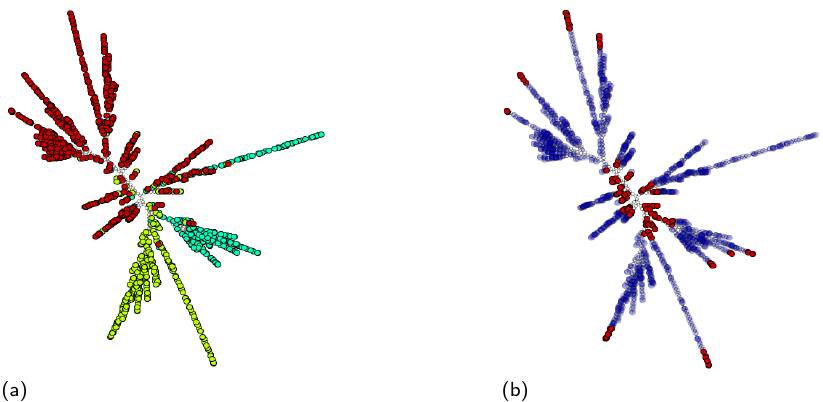
Figure 13. Bag space projection of MILTree for the Biocreative dataset using MILTree-SI, with the projection of its ground truth ( a ) and the selected training data (red bags) ( b